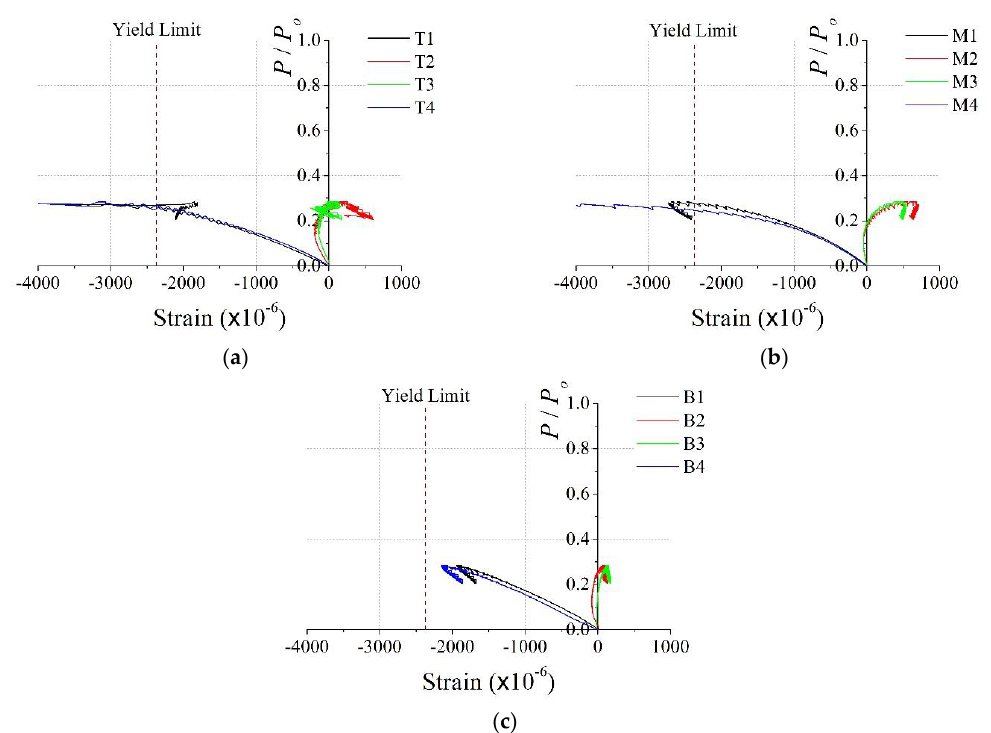
Figure 14. Dimensionless axial load vs. vertical stain for CL25-TB: ( a ) top (T1 – 4); ( b ) middle (M1 – 4); and ( c ) bottom (B1 – 4).